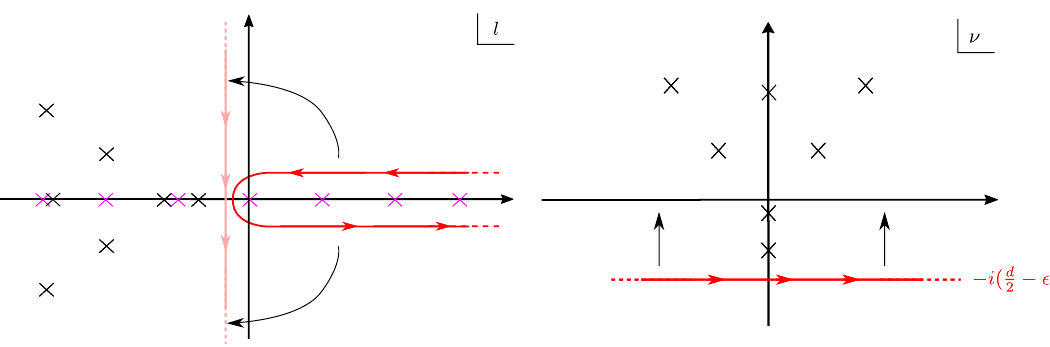
Figure 22 . On the left: using the Watson-Sommerfeld trick we rewrite the spectral representation of the two-point function on the sphere as a contour integral. We show the contour deformation (cid:2) (cid:3) in the complex l plane and the singularities of π f S ( l ) ( − 1) l Ω S , which include poles at all l sin( πl ) the integers coming from the sin prefactor, denoted in purple. We assume no further singularity of f S ( l ) in the region where we perform the deformation. On the right: after changing variable to (cid:0) (cid:1) ν = − i l + d , we sketch of the analytic structure of the function f ( ν ) appearing in the integral 2 representation (C.8) of a two-point function in dS. The only singularities in the lower-half plane (cid:0) (cid:1) are in the interval iν ∈ 0 , d . After the deformation showed on the left, the contour runs on the 2 (cid:0) d (cid:1) line Im ν = − − (cid:15) for a small positive (cid:15) . We can then deform it on the real ν axis, therefore 2 (cid:0) (cid:1) singularities in iν ∈ 0 , d . Poles on the real ν axis, i.e. on the principal series, can be encountered 2